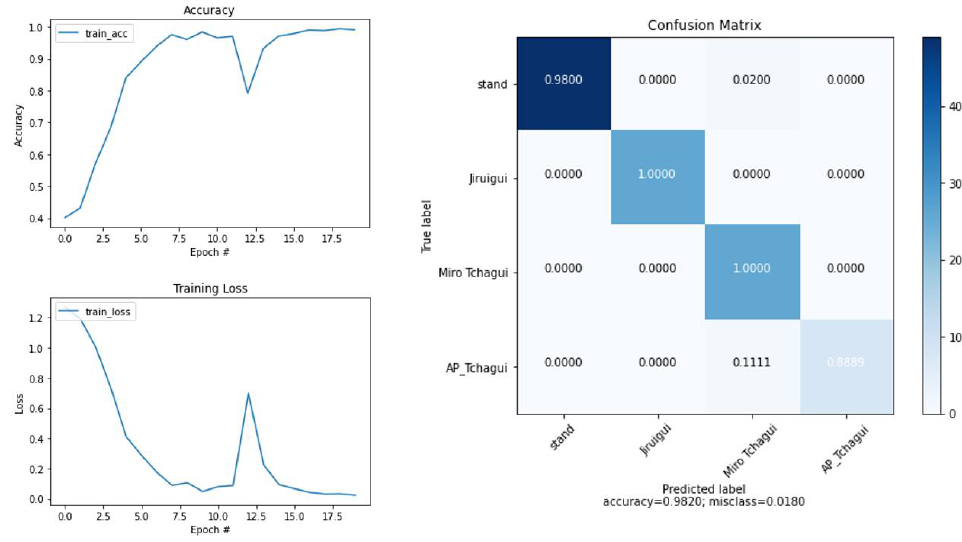
Figure 16. Training results of confusion matrix from CNN LSTM model.